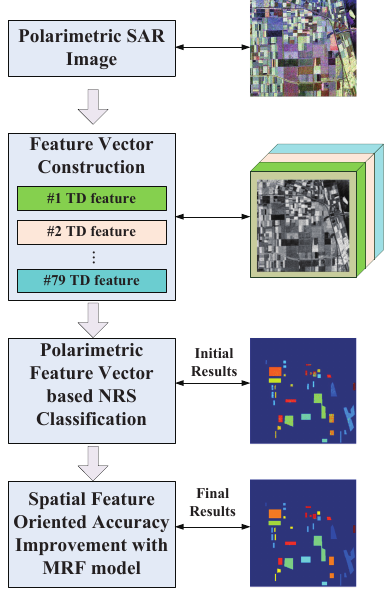
Figure 1. Diagram of the proposed